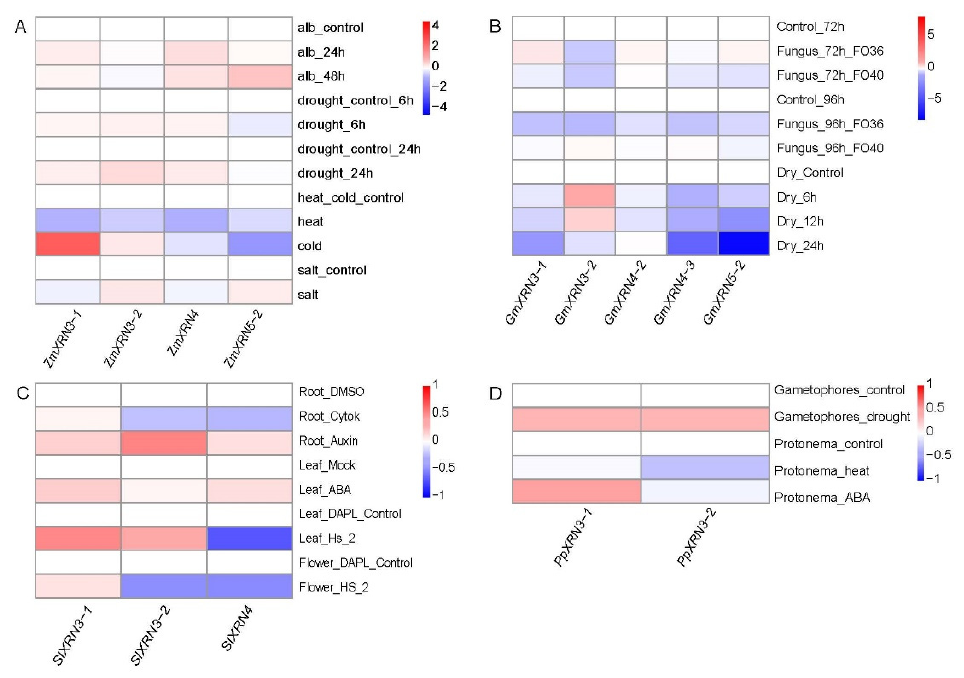
Figure 6. Cluster analysis of the ZmXRNs , GmXRNs, and SlXRNs expression patterns. ( A ) Heatmap displaying expression profiles of ZmXRNs in response to diverse abiotic stress. ( B ) Heatmap showing expression profiles of GmXRNs in response to fungus and Drought treatment. ( C ) Heatmap showing expression profiles of SlXRNs in response to phytohormones and heat shock in different tissues. ( D ) Heatmap showing expression profiles of PpXRNs in response to drought, heat, and ABA.